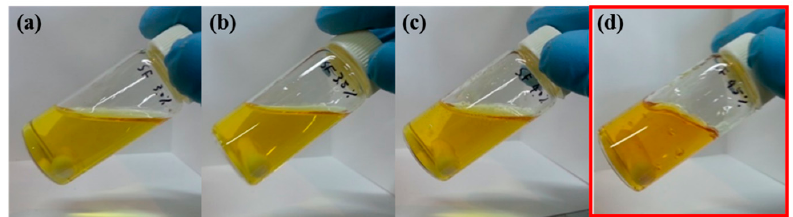
Figure 2. Concentration effect of the SF/formic acid solution on gelation: ( a ) 3% SF; ( b ) 3.5% SF; ( c ) 4% SF; and ( d ) 4.5% SF. The red part indicates a gelated SF solution at a 4.5% SF concentration.